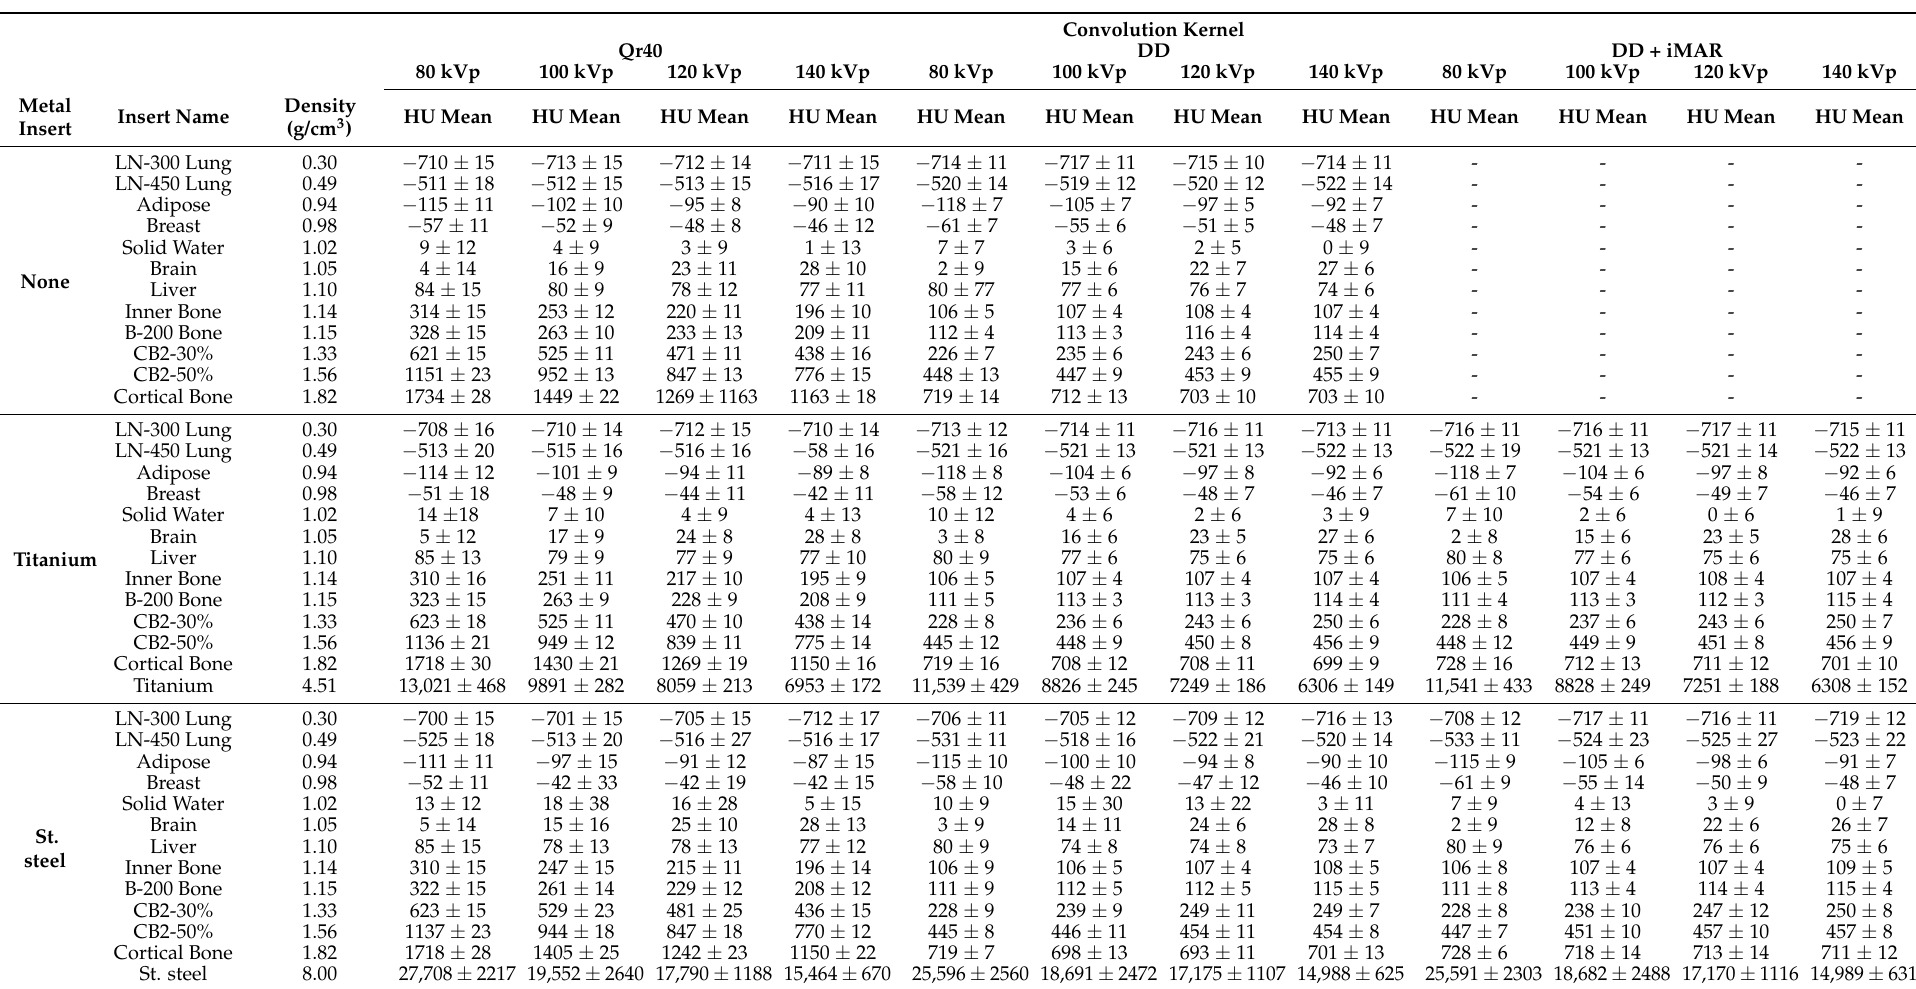
Table 2. The mean HU in the selected cylindrical ROIs in the Cheese phantom with inserts of densities ranging from 0.30 g/cm 3 to 8 g/cm 3 . Data were divided on the basis of the kVp used during the acquisition of the image, on the basis of the reconstruction algorithm (Qr40, DD or the combined algorithm DD + iMAR), and on the basis of the metal insert placed in the phantom. The combined algorithm DD + iMAR was used only for CT scans acquired with the metal